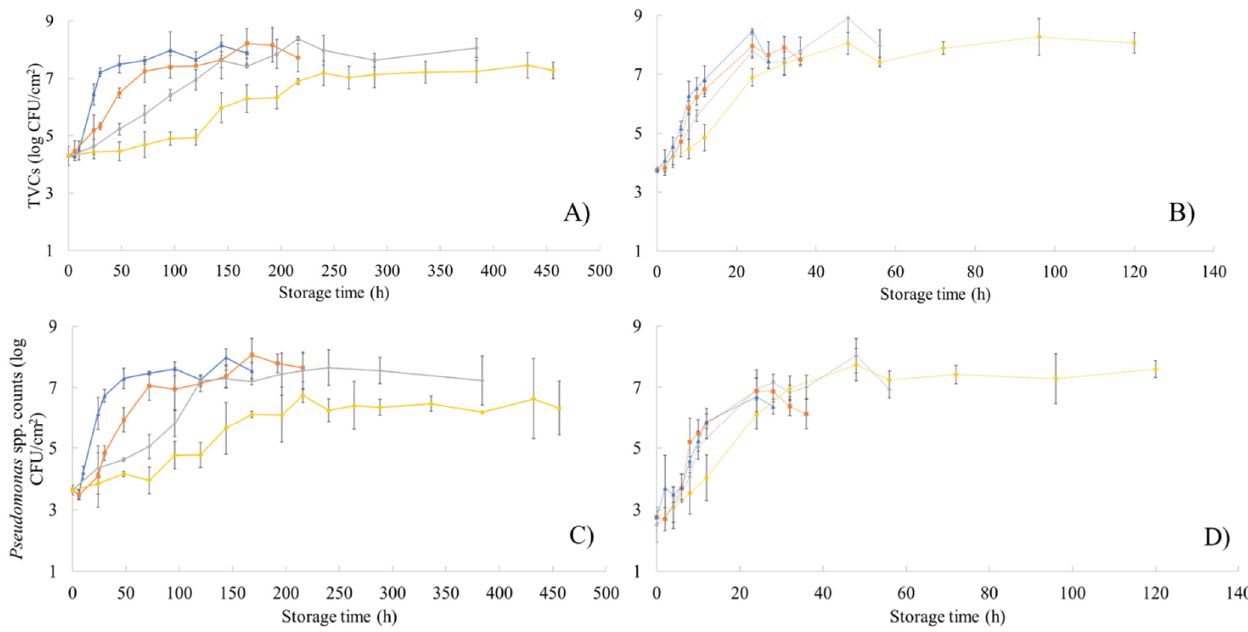
Figure 2. Changes in the population (log CFU/cm 2 ) of total viable counts (TVCs) ( A , B ) and Pseudomonas spp. ( C , D ) in chicken thigh samples during storage at different isothermal conditions ( A , C : 0, 5, 10 and 15 °C); B , D : 20, 25, 30, and 35 °C). Data points are average values of four replicates of samples ± standard deviation.